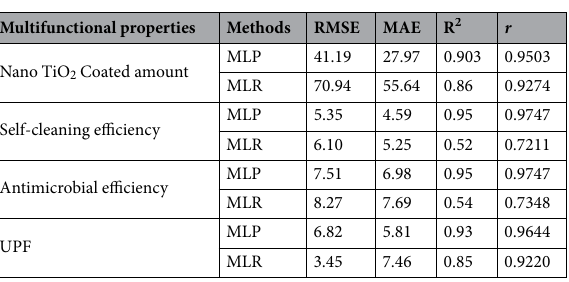
Table 4. The performance measures of MLP and MLR for functional properties of nano TiO 2 coated